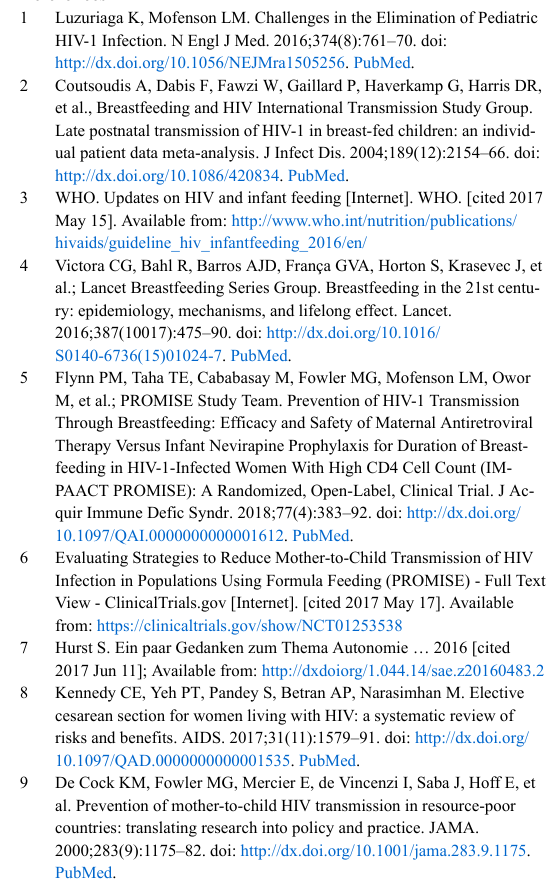
Table 2: Suggested procedures to address breastfeeding in HIV-infected mothers with a strong wish to breastfeed their children. Prerequisite conditions to minimise HIV Adherent in taking her combined antiretroviral therapy MTCT risk (“optimal scenario”)